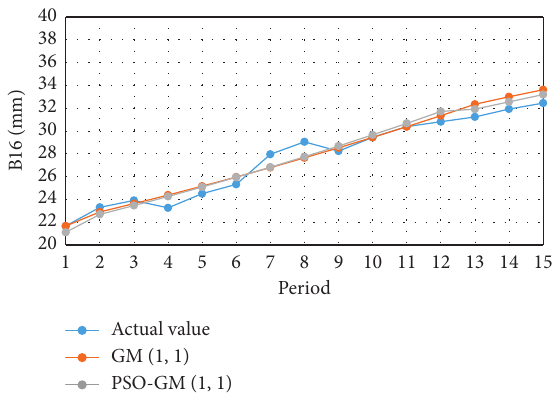
Figure 16: Comparison of actual and predicted values.